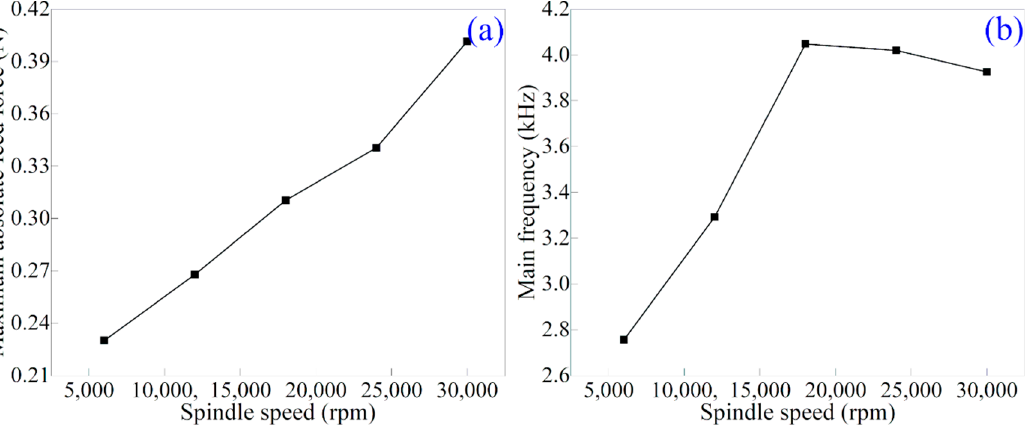
Figure 8. FE simulation results of the effect of spindle speed on ( a ) the maximum absolute feed force and ( b ) the main frequency of feed